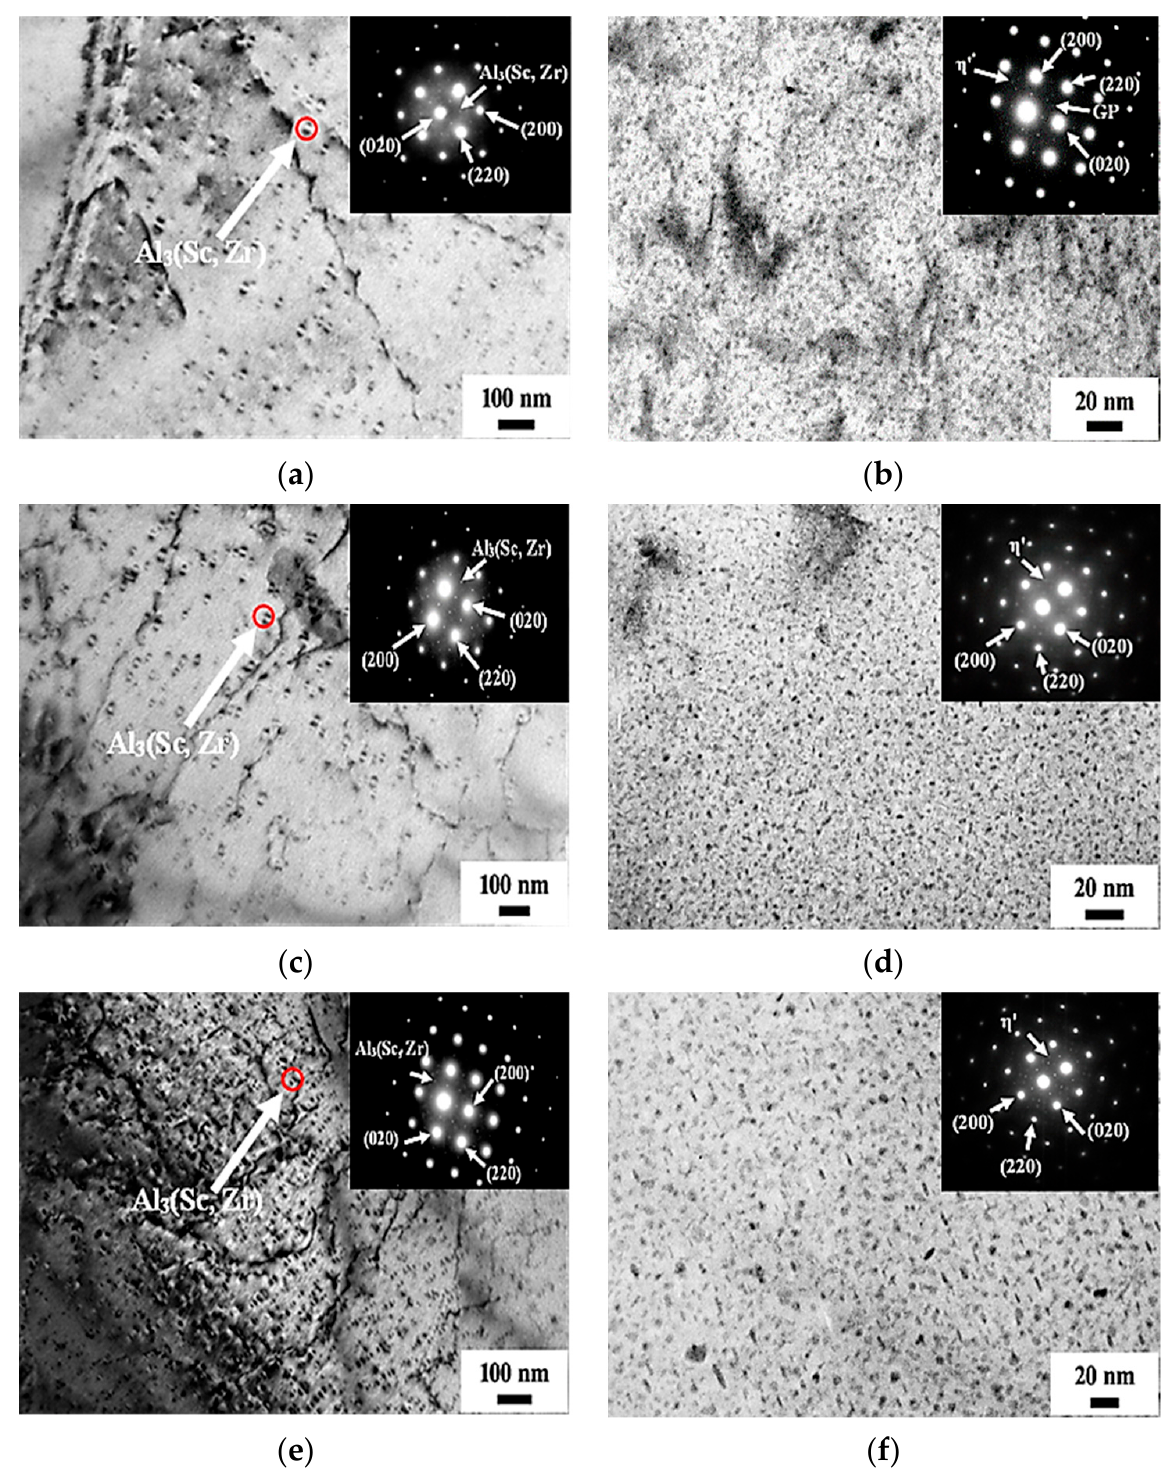
Figure 3. Morphology and electron diffraction pattern of precipitated phase in T6 alloy. ( a , b ) Solution + aging 18 h; ( c , d ) solution + aging 24 h; ( e , f ) solution + aging 36 h.